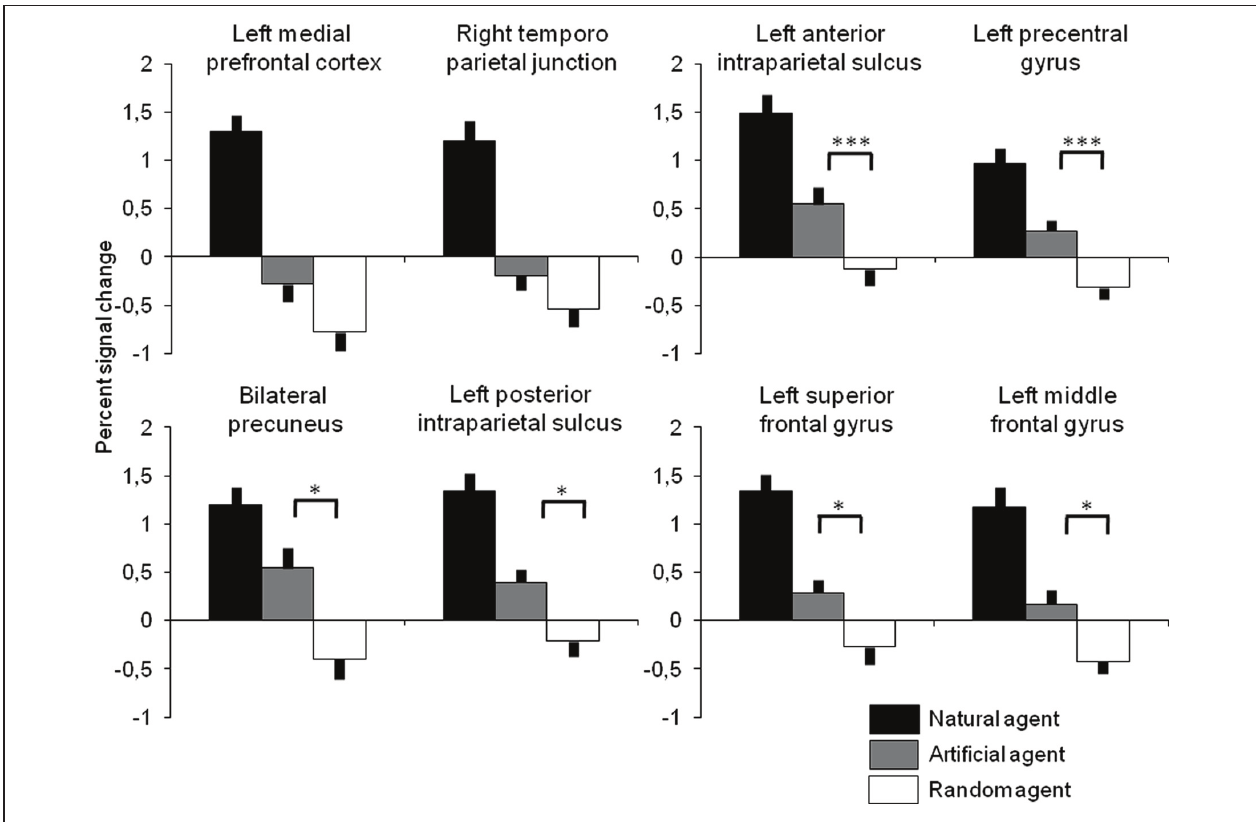
p < 0 . 001 (not represented). Significant pairwise comparisons between Artificial and Random agents are presented at significant ( ∗ p < 0 . 05) and highly significant ( ∗∗∗ p < 0 . 001)